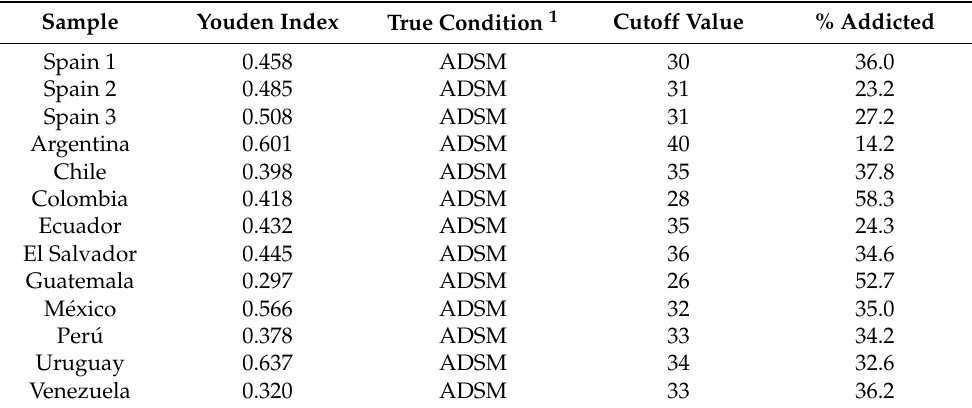
Table 6. Youden Index, cutoff values, and percentage of ‘addicted’ youth, when the same definition is given for the true problematic condition across